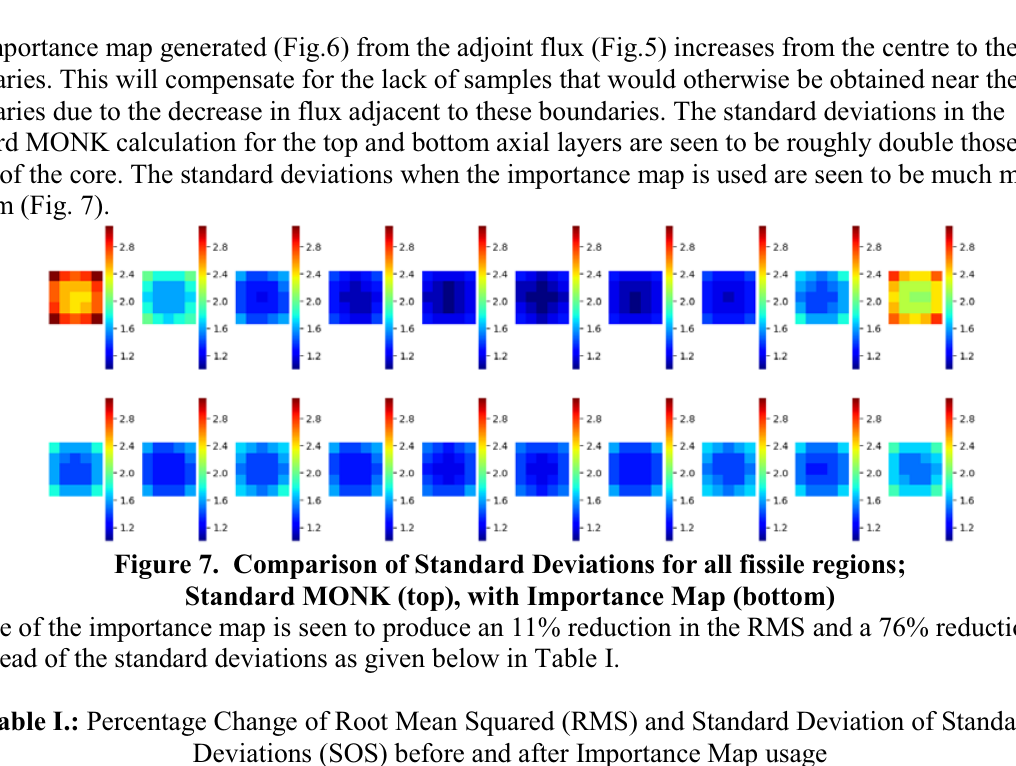
Table I.: Percentage Change of Root Mean Squared (RMS) and Standard Deviation of Standard Deviations (SOS) before and after Importance Map usage RMS SOS Percentage Change -11.37% -76.18%